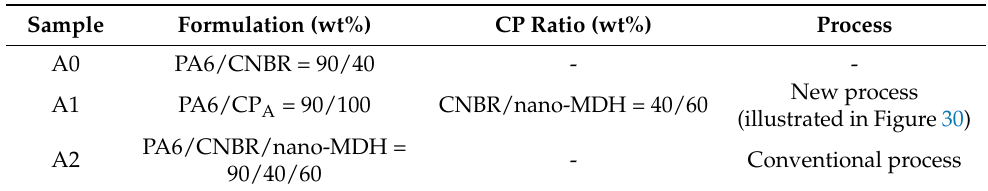
Figure 30. Schematic of the preparation of polyamide 6/CP A and EVA/CP B nanocomposites: CP A , CNB-UFPR/nano-MDH = 40/60 (wt%); CP B , NB-UFPR/nano-MDH = 40/60 (wt%). Reprinted with permission from Ref. [221]. Copyright 2006, Elsevier. Table 8. Compositions of polyamide 6 nanocomposites. Reprinted with permission from Ref. [221]. Copyright 2006, Elsevier.